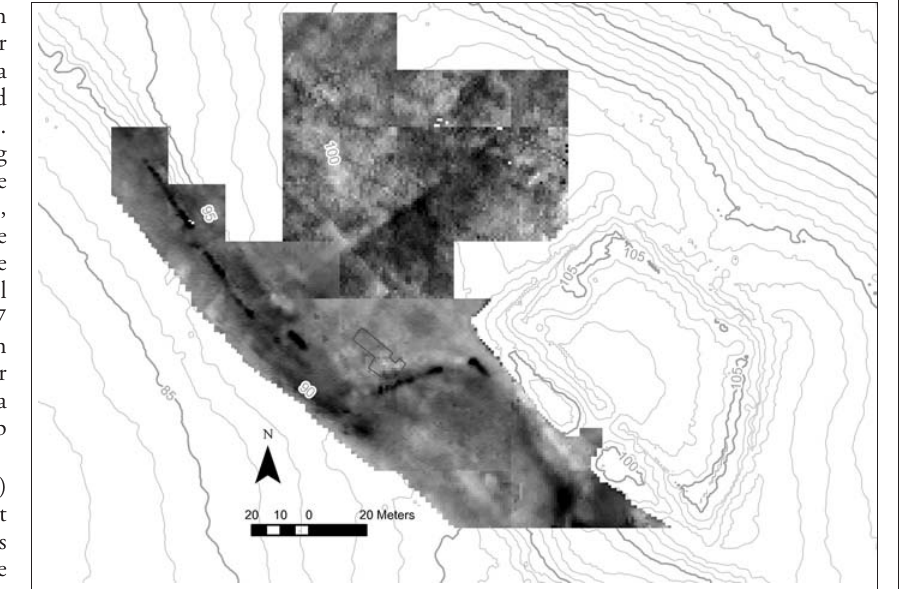
Figure 4 The resistance survey of the southwest slopes of the